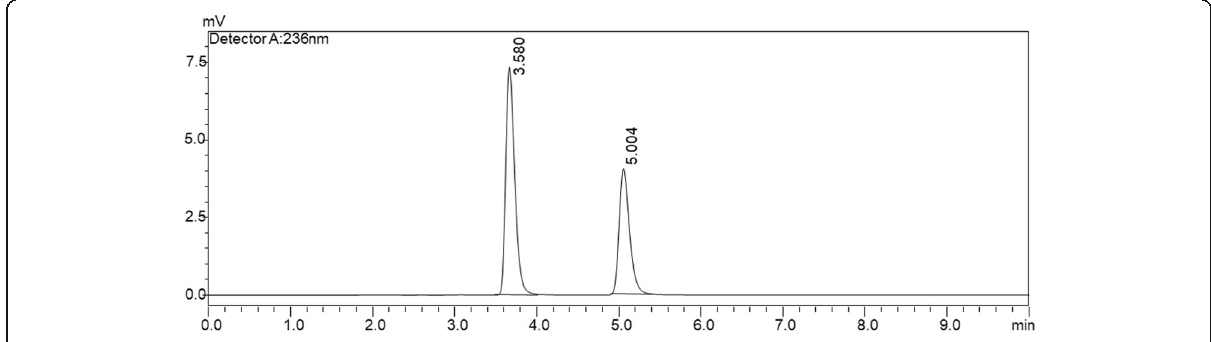
Fig. 3 Chromatogram of dapagliflozin (Rt-3.5) and saxagliptin (Rt-5) under optimized